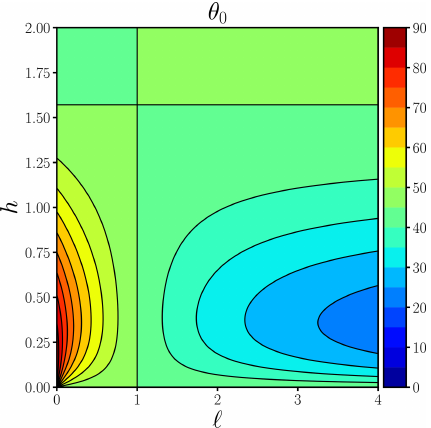
Figure 1. Surface deflection angle θ 0 (in degrees) as a function of the lower-layer non-dimensional viscous length (cid:96) and the non- dimensional depth of the upper layer h